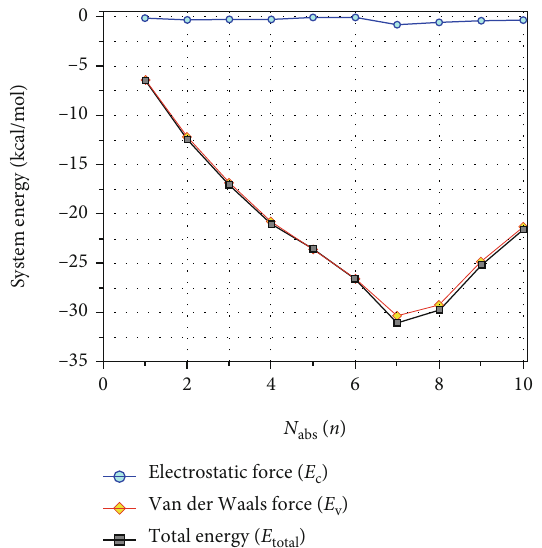
Figure 7: Energy changes during unit cell adsorption of di ff erent amounts of CO 2